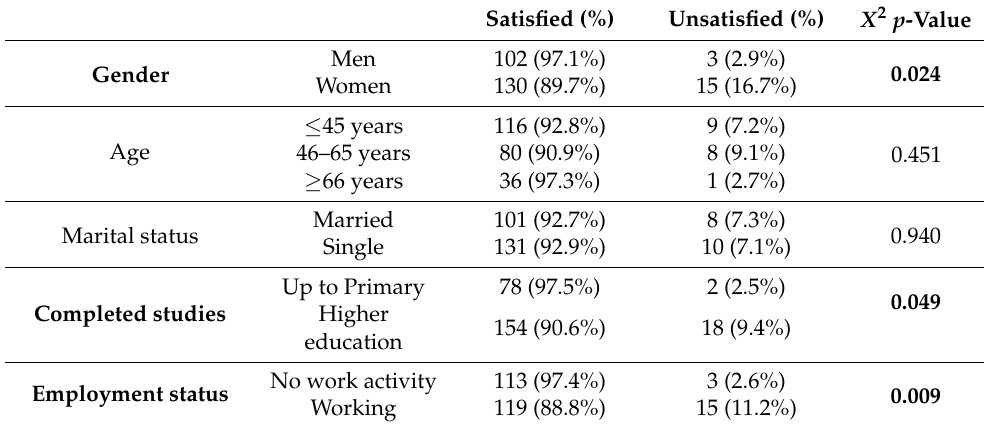
Table 3. Analysis of the influence of recoded sociodemographic data on overall